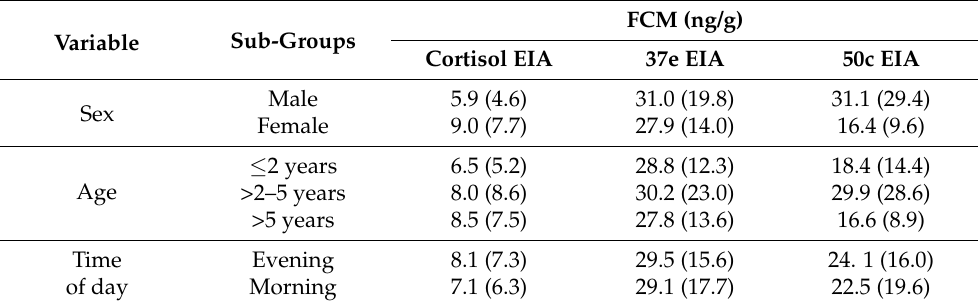
Table 3. Median (IQR) for FCM (faecal cortisol metabolites) values measured by cortisol, 37e and 50c EIAs (enzyme immunoassays) by sex, age category and time of